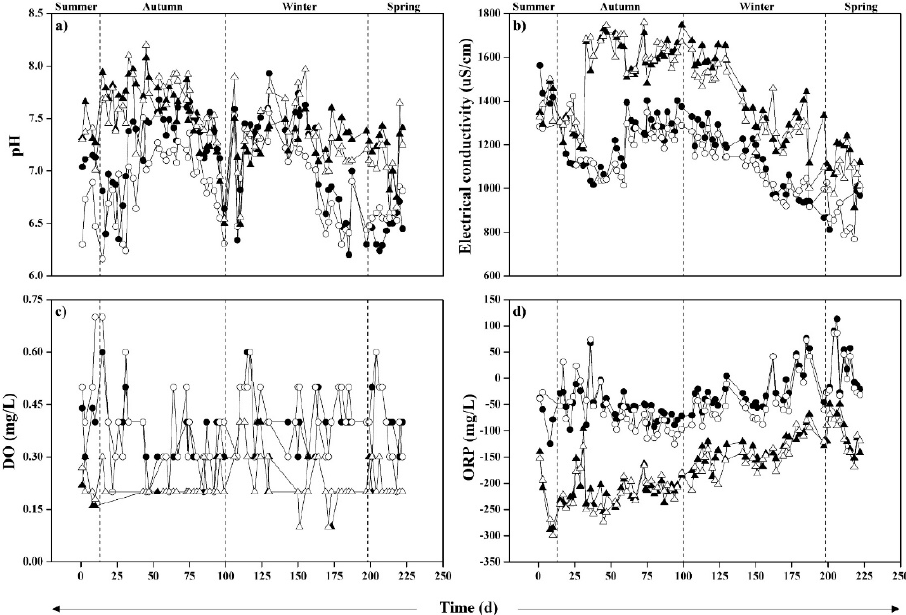
Figure 2. In situ parameters variation: ( a ) pH; ( b ) electrical conductivity; ( c ) dissolved oxygen; and ( d ) oxide reduction potential. Where VSSF 1 ( △ ); VSSF 2 ( ▲ ); HSSF 1( ○ ); and HSSF 2 ( ● ).